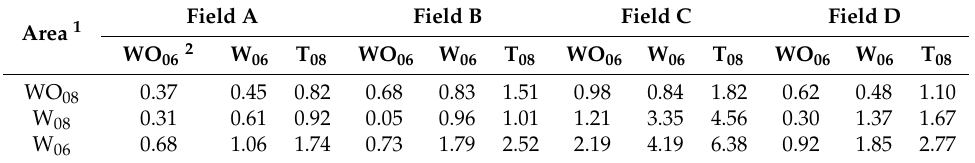
Figure 2. Spatial distribution of the change detection analysis for four wheat fields. Table 1. Crop-weed area change comparison between 2006 and 2008 in the four wheat